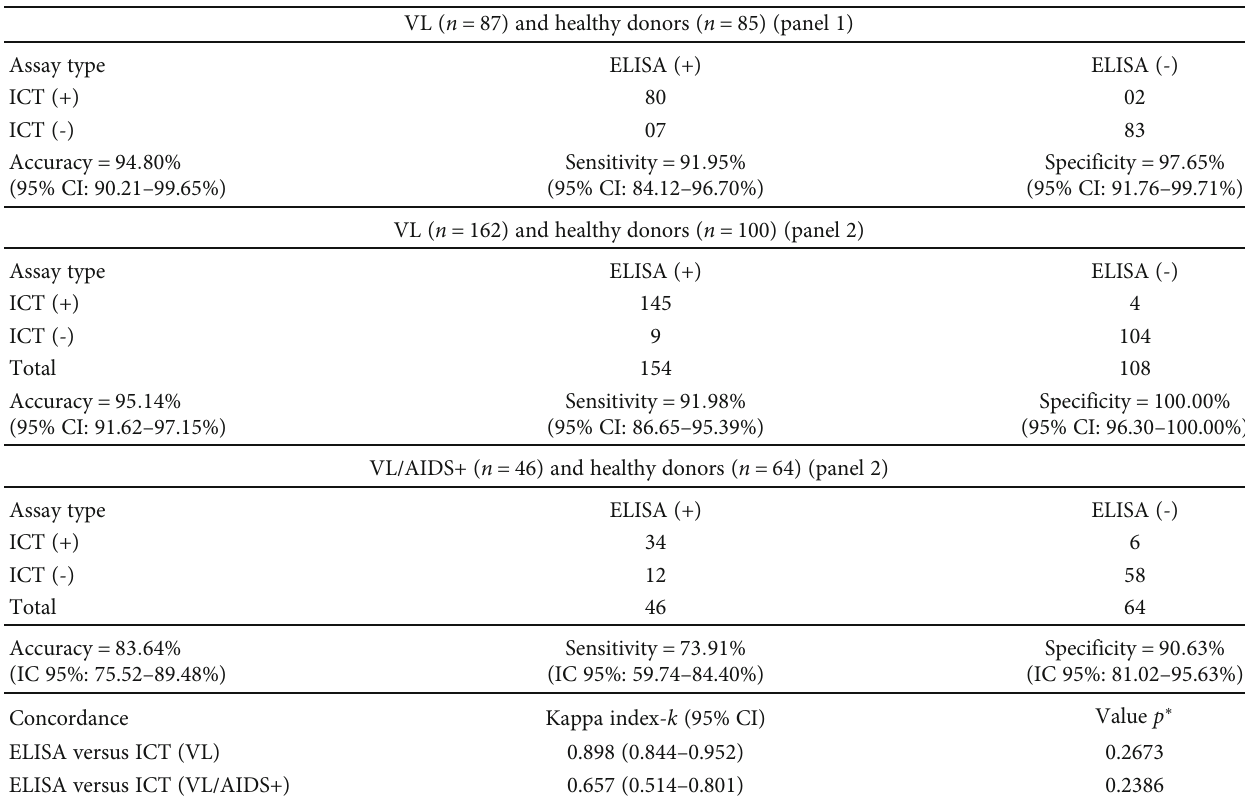
Table 5: Sensitivity, speci fi city, accuracy, and agreement of the VL-ICT versus the VL-ELISA using human samples from L . infantum - infected patients and healthy donors and VL/AIDS+), from panels 1 and 2.